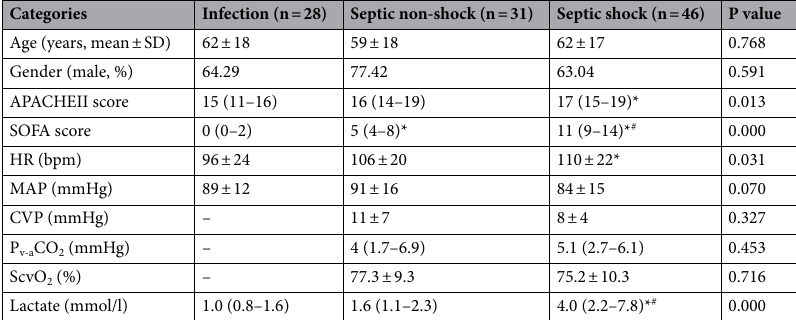
Table 1. Patient characteristics at ICU admission. Data was presented by mean standard deviation, n (%), or median (interquartile range). For normally distributed data, comparisons among multiple groups were conducted by one-way analysis of variance, and those between two groups were carried out with the Least Significant Difference (LSD) post hoc test. For data without normal distribution, Post hoc tests and between- group analyses were performed by Mann–Whitney nonparametric tests and Bonferroni corrected. APACHE Acute Physiology and Chronic Health Evaluation, SOFA sequential organ failure assessment score, HR heart rate, MAP mean arterial blood pressure, CVP central venous pressure, P v-a CO 2 venous-to-arterial carbon dioxide difference (Pv-aCO2), ScvO 2 central venous blood oxygen saturation. *P < 0.05 for the comparison between infection and septic non-shock, between infection and septic shock. # P < 0.05 for the comparison between septic non-shock and septic